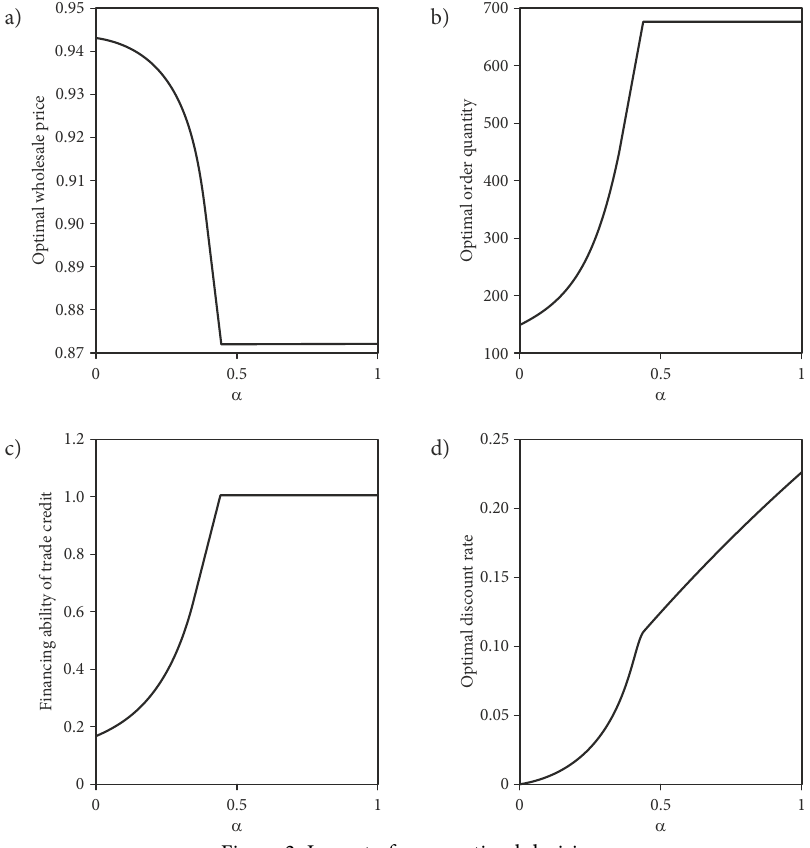
Figure 2. Impact of a on optimal